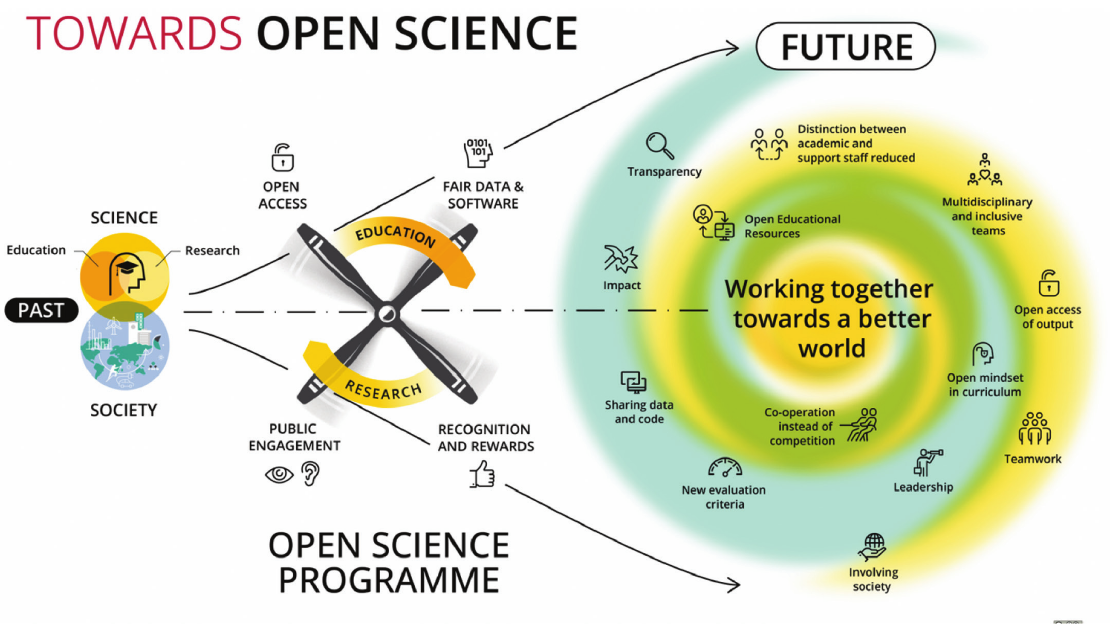
Figure 1. Infographic illustrating the mission and vision of the Open Science Programme at Utrecht University (Source: Utrecht